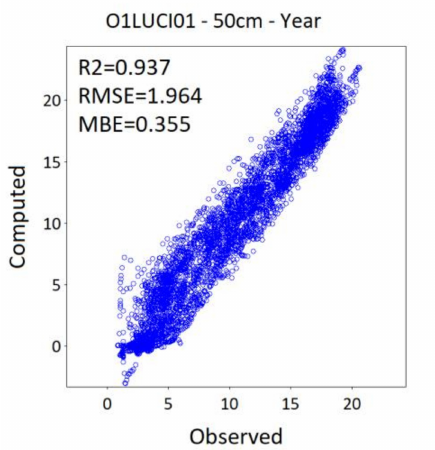
Figure A12. Validation at site O1LUCI01 for 50 cm soil depth.